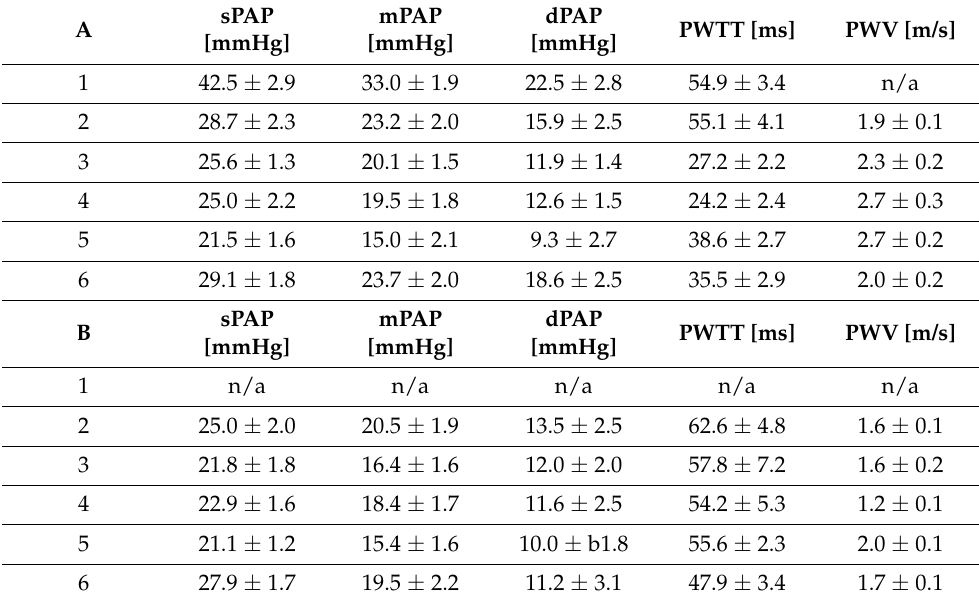
Table 1. Baseline mean values with respective standard deviations for each animal at resting con- ditions before TXA- (A) and hypoxia-induced (B) PH. Missing data in animal 1 (n/a) are due to unavailable nitrogen gas and missing catheter distance in this experiment.